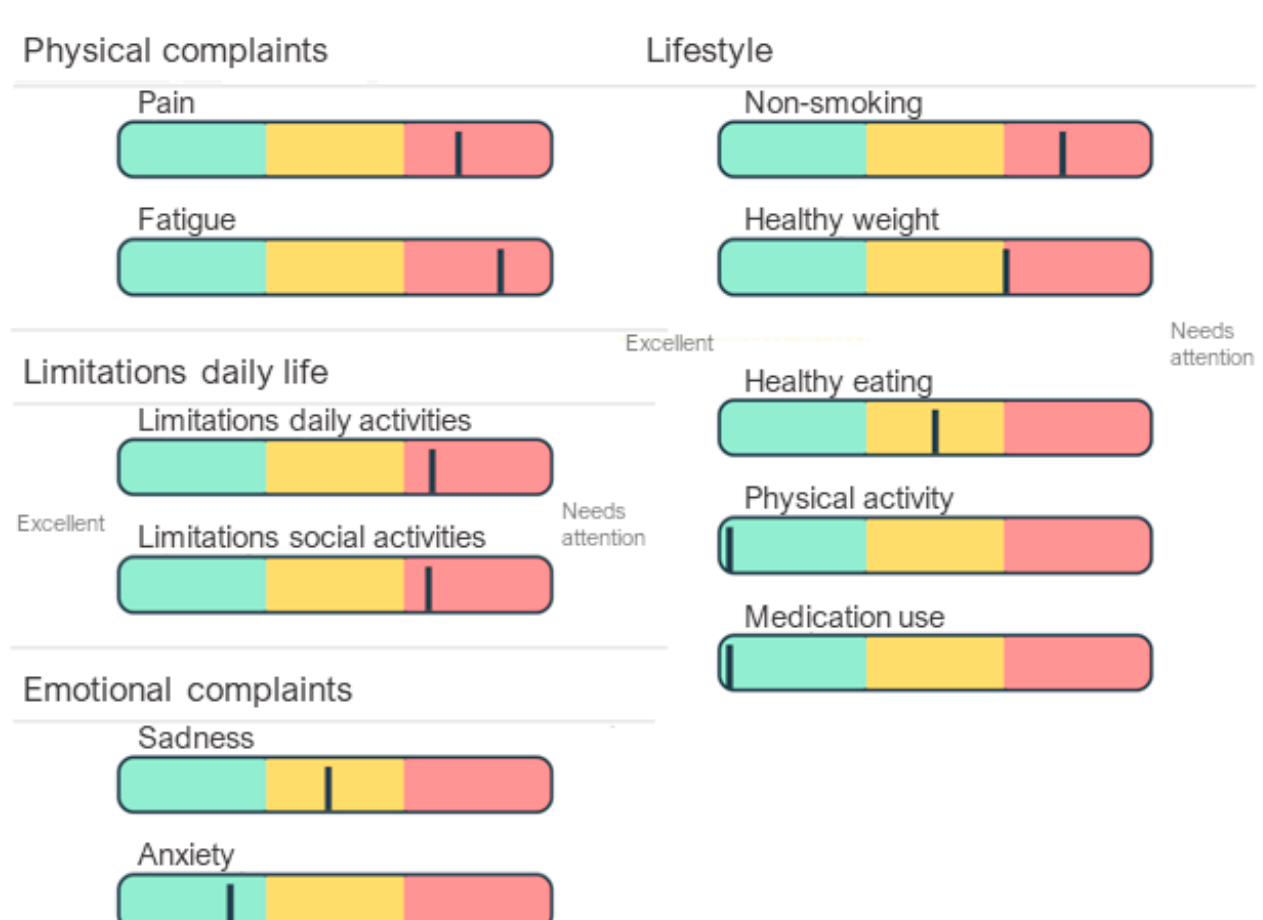
Figure 5. An example of personal profile charts. This patient shows an increased-risk profile with moderate depressive symptoms (which may be influenced by severe physical complaints and limitations in daily life), heavy smoking, obesity, and moderate adherence to dietary prescriptions.